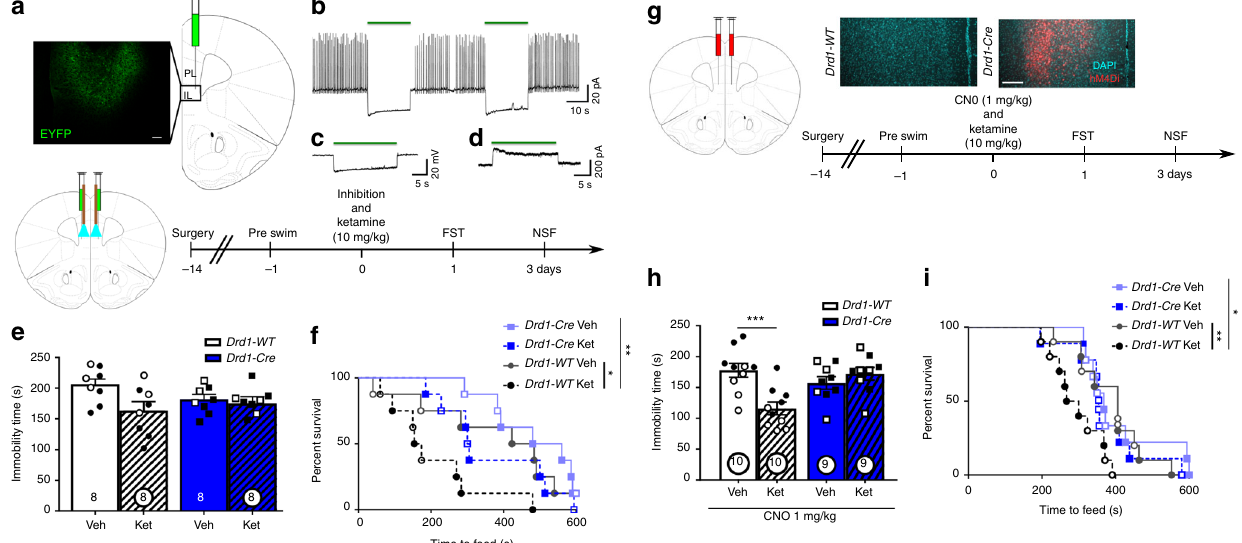
Fig. 3 Inhibition of mPFC Drd1 expressing cells blocks the antidepressant effect of ketamine. a Representative AAV-ARCH viral expression in ventral mPFC. b Action potentials induced by current injection in voltage clamp are potently inhibited by ARCH activation. c Current clamp recordings demonstrate hyperpolarization associated with light application. d Voltage clamp recordings demonstrate outward current during light application. e FST immobility time 24 h after photoinhibition and ketamine (Factorial ANOVA interaction p = 0.11). f Time to feed in the NSF test 72 h after photoinhibition and ketamine administration (Mantel – Cox (log rank) overall p < 0.01, WT-veh vs. WT-ket p < 0.05). g Representative AAV-hM4Di expression. h FST immobility time 24 h after hM4Di inhibition and ketamine (Factorial ANOVA interaction p < 0.01, post-hoc t -test p < 0.001). i Time to feed in the NSF 72 h after hM4Di inhibition and ketamine (Mantel – Cox (log rank) overall p < 0.05, WT-veh vs. WT-ket p < 0.01). e , f n = 5 males, 3 females per group; h , i n = 5 males, 5 females per WT group, n = 4 males, 5 females Cre ket, n = 5 males, 4 females Cre veh; * p < 0.05, ** p < 0.01, *** p < 0.001. Error bars represent mean ± SEM, scale bar 100 µ M. Male — closed data points, female — open data points NATURE COMMUNICATIONS| (2019) 10:223